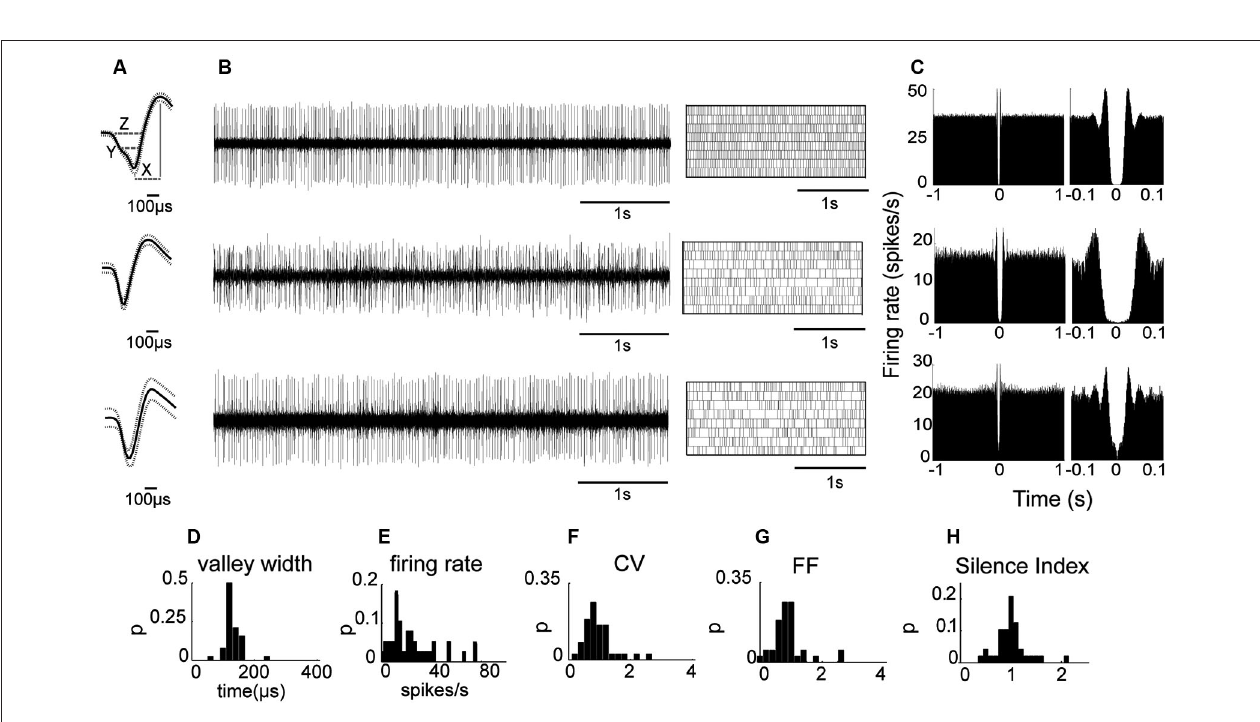
FIGURE 2 | EP neuronal firing characteristics in awake rats. (A) Examples of the firing of three EP neurons. From left to right: Average waveform. Inset (top): X represents the valley to peak duration, Y the valley width and Z the zero-cross parameter. (B) Continuous raw signal